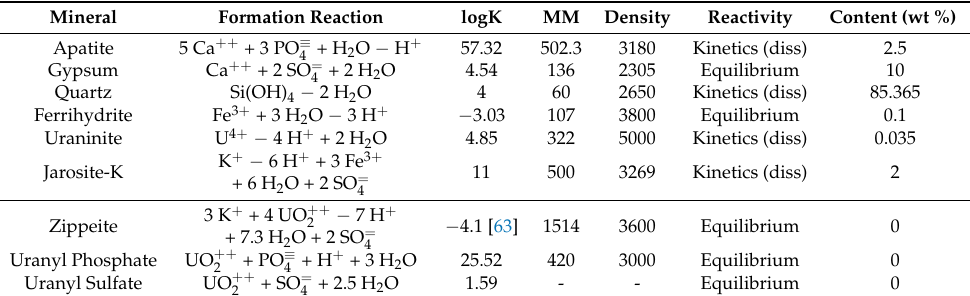
Table 2. Thermodynamic data of considered mineral species. Molar masses (MM) are given in g/mol and densities are given in kg/m 3 . Unless explicitly mentioned, data were collected from the Prodata database (v1.4) [13].